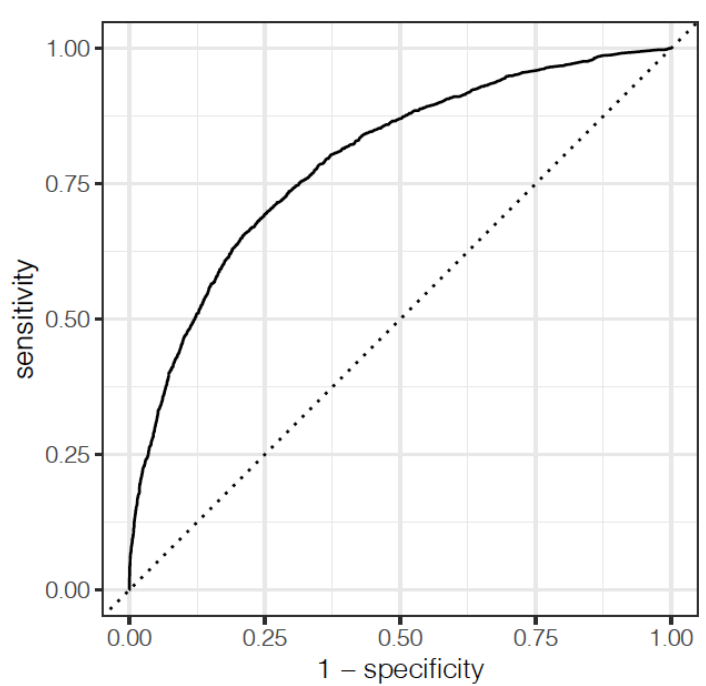
Figure 3. Binary logistic regression ROC curve [AUC 0.793].